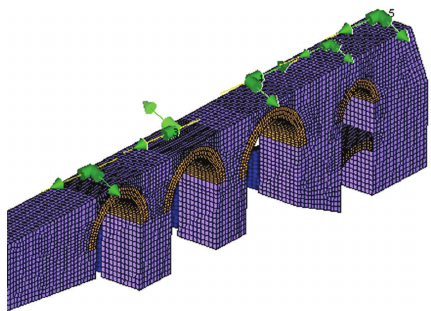
Figure 7: Uniaxial accelerometers placed to the top of the aqueduct